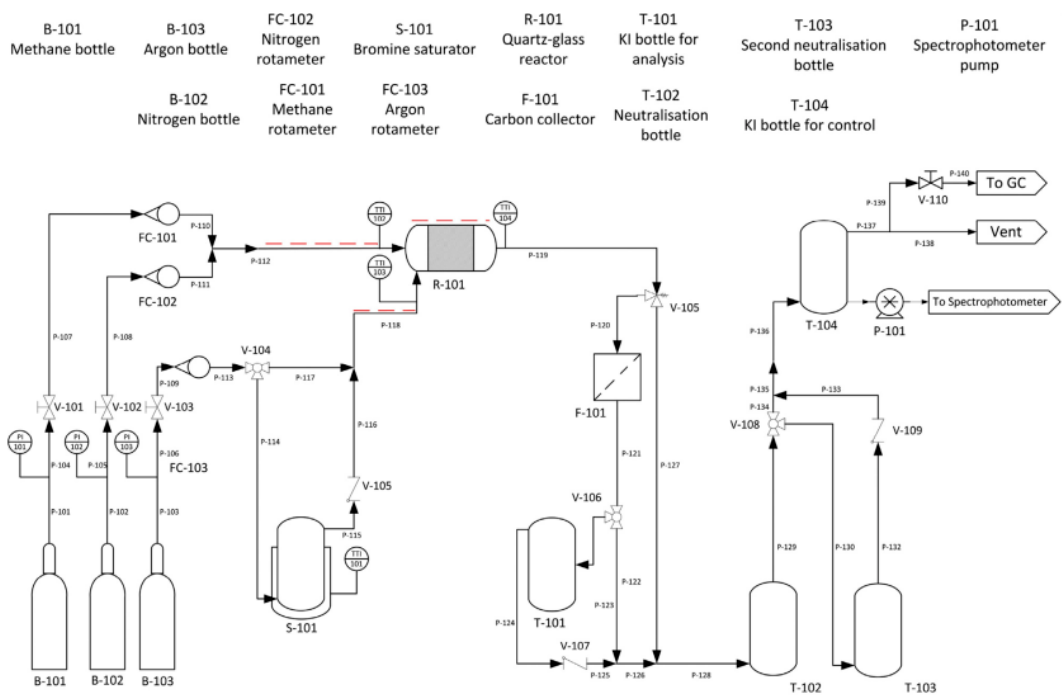
Figure 9. Flowsheet of the bench-scale plant for methane bromination. Reprinted from [94].